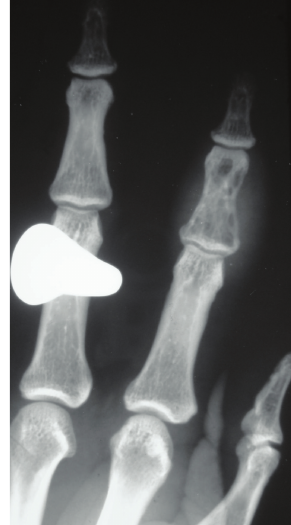
Figure 3: Plain radiograph of the hand of a patient with sickle cell anaemia showing patchy lucency and associated soft tissue swelling consistent with osteomyelitis of the middle phalanx of the index